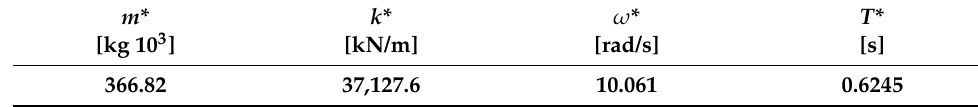
Table 9. Dynamic parameters of the equivalent SDOF system